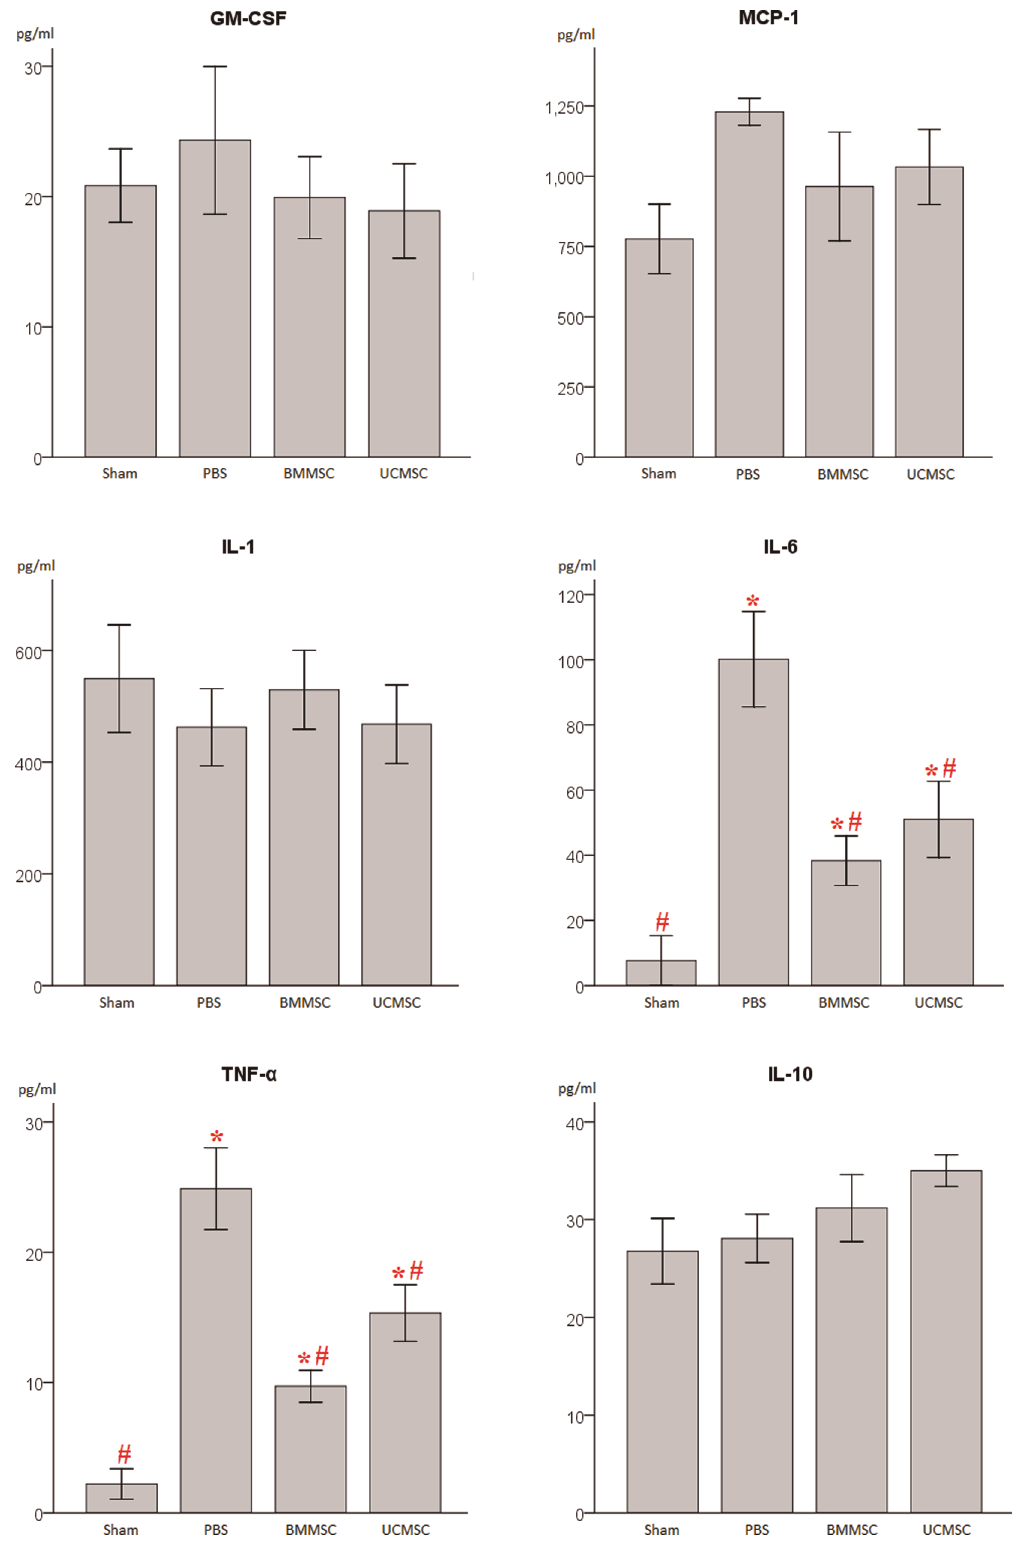
Figure 3. Changes of circulating inflammation-associated cytokine profiles in rats 18 hours after CLP. Compared with sham-operated rats, serum levels of IL-6 and TNF- a were elevated in rats undergoing CLP (i.e. BMMSC, UCMSC and PBS groups). Compared with rats receiving PBS only after CLP, the levels of IL-6 and TNF- a were significantly lower in rats receiving MSCs, either BMMSCs or UCMSCs. There were no significant